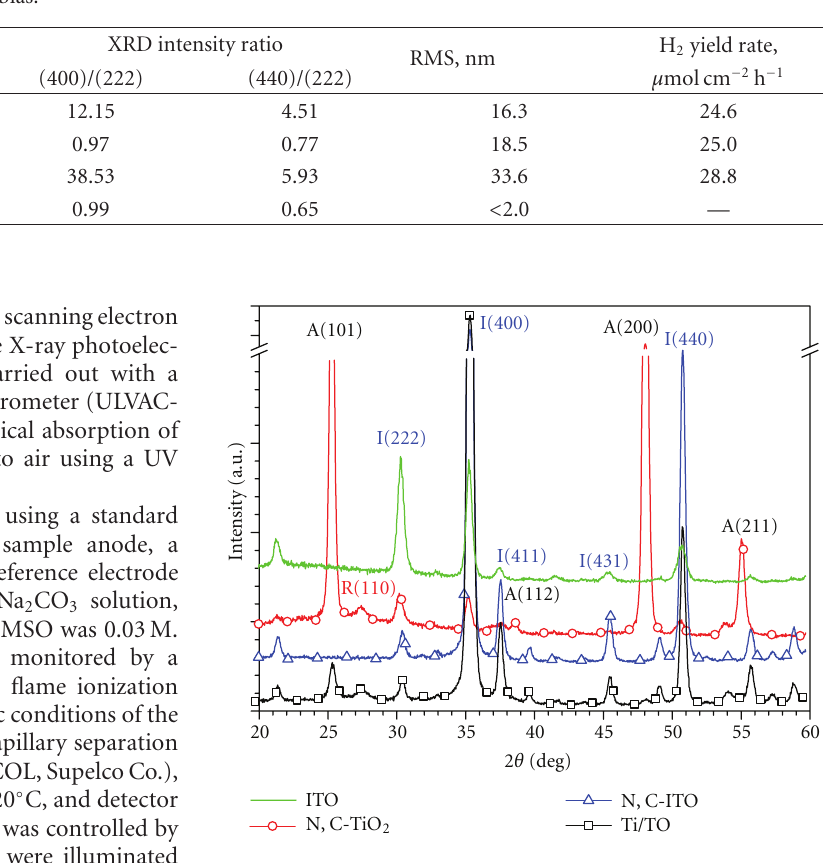
Table 1: Physical and microstructural properties of samples along with their H 2 yield rates in 4.0 N Na 2 CO 3 solution under irradiation of